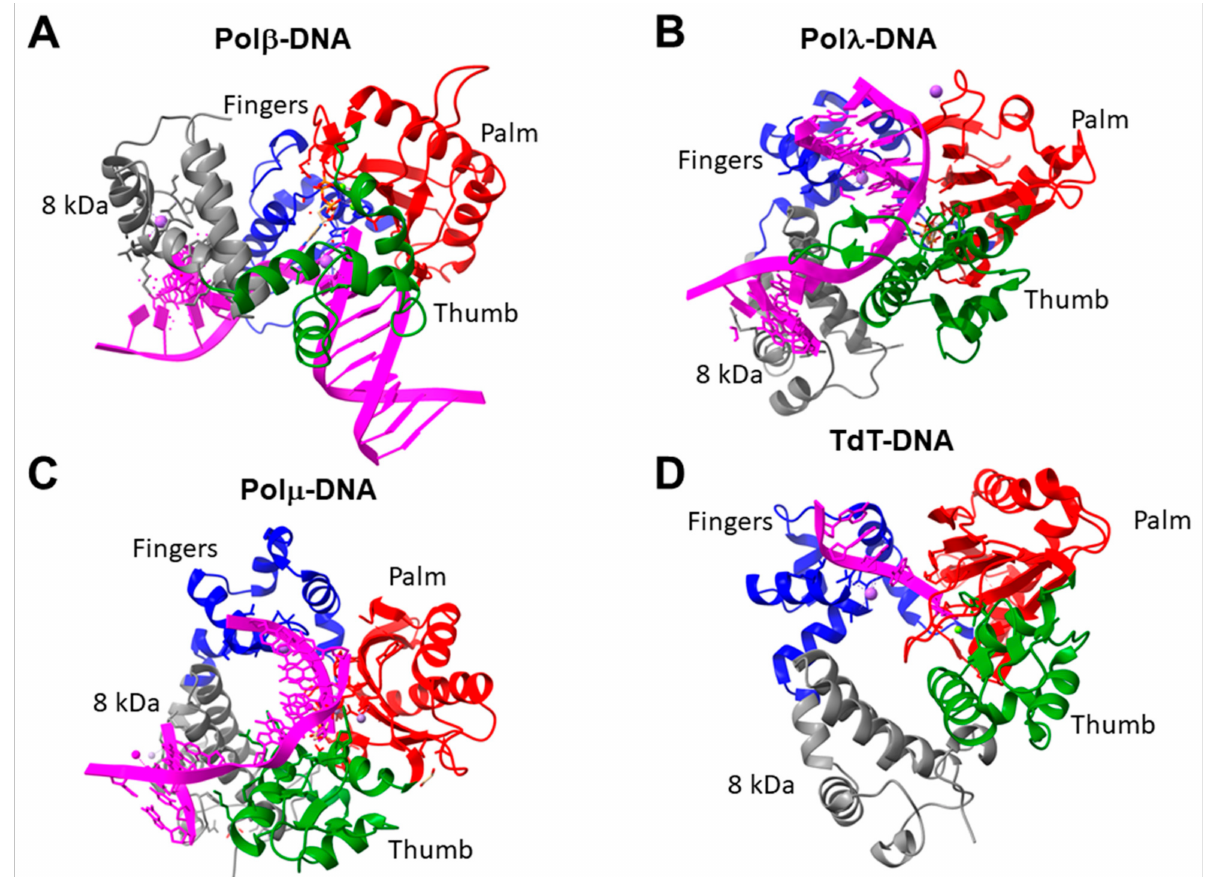
Figure 7. Three-dimensional structure of the binary complex of ( A ) Pol β (PDB ID 1bpy), ( B ) Pol λ (PDB ID 1xsn), ( C ) Pol µ (PDB ID 5tyw), and ( D ) TdT (PDB ID 4i2a) with DNA. The thumb (green), palm (red), fingers (blue) and exonuclease (gray) domains are presented.